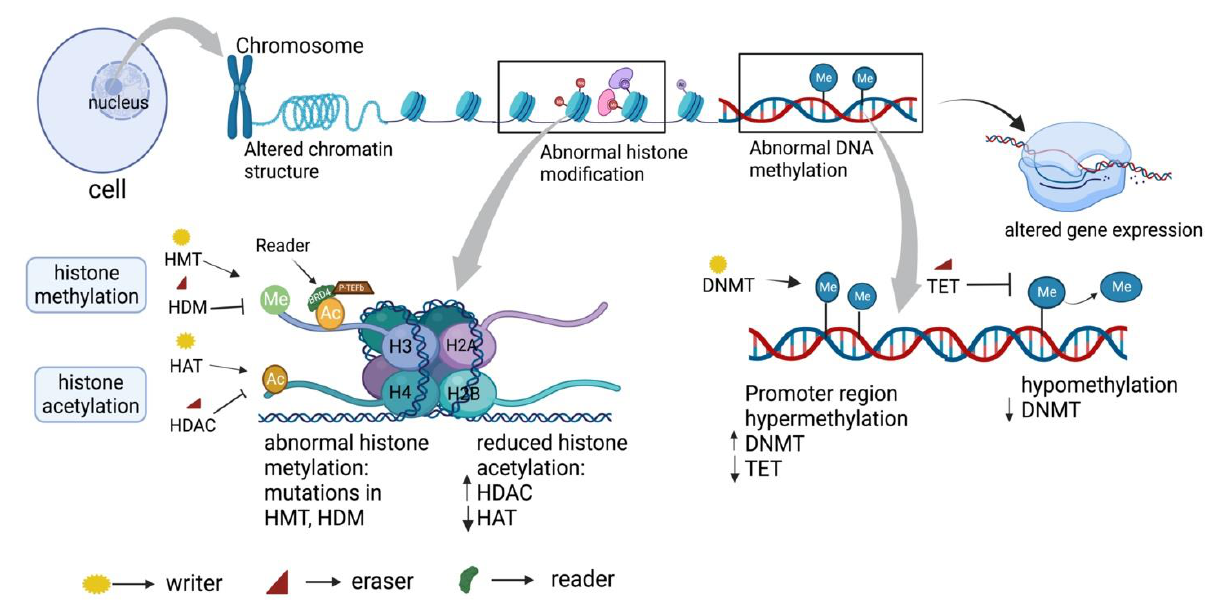
Figure 2. Epigenetic regulation in cancer. DNA within the nucleus of a cell is found to be densely wrapped in the chromatin structure with nucleosome as the basic unit. Alteration in the chromatin structure leads to aberrant gene expression, which is mainly regulated by an epigenetic mechanism. This includes DNA methylation, and histone modification carried out by epigenetic regulators such as writers, erasers, and readers. Histone modification (histone acetylation and histone methylation) maintains chromatin accessibility and gene expression by modulating N and C terminal histone tail.